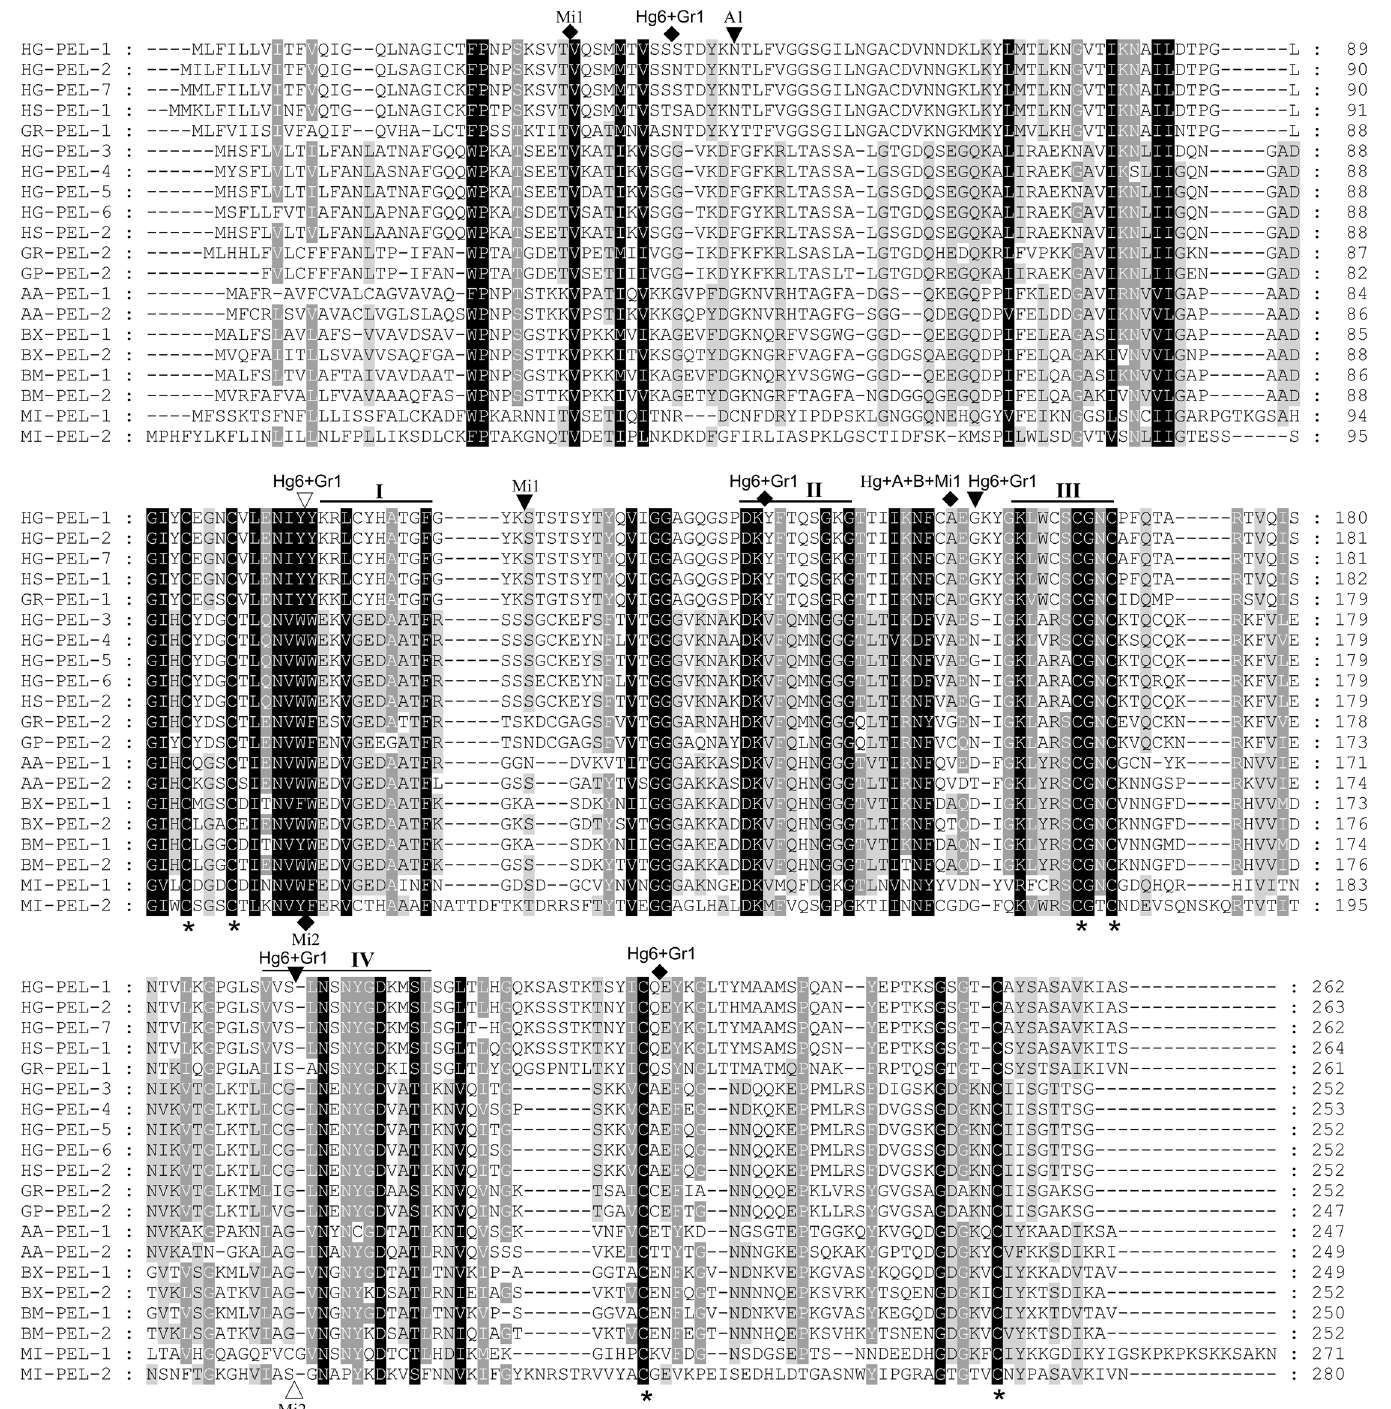
Fig 1. Alignment of the putative protein sequences of the pectate lyases that belong to the polysaccharide lyase family 3. HG-PEL-1 [AAK08974], HG-PEL-2 [AAM74954] and HG-PEL-5 [ADW77534] correspond to Heterodera glycines ; HS-PEL-1 [ABN14273] and HS-PEL-2 [ABN14272] correspond to H . schachtii ; GR-PEL-1 [AAF80747] and GR-PEL-2 [AAM21970] correspond to Golobedera rostochiensis ; GP-PEL-2 [ACU64826] corresponds to G . pallida ; BX-PEL-1 [BAE48369] and BX-PEL-2 [BAE48370] correspond to Bursaphelenchus xylophilus ; BM-PEL-1 [BAE48373] and BM-PEL-2 [BAE48375] correspond to B . mucronatus ; AA-PEL-1 [BAI44999] and AA-PEL-2 [BAI44997] correspond to Aphelenchus avenae ; MI-PEL-1 [AAQ09004] and MI-PEL-2 [AAQ97032] correspond to Meloidogyne incognita . Identical residues are highlighted in black. Black bars (I to IV) indicate the conserved regions